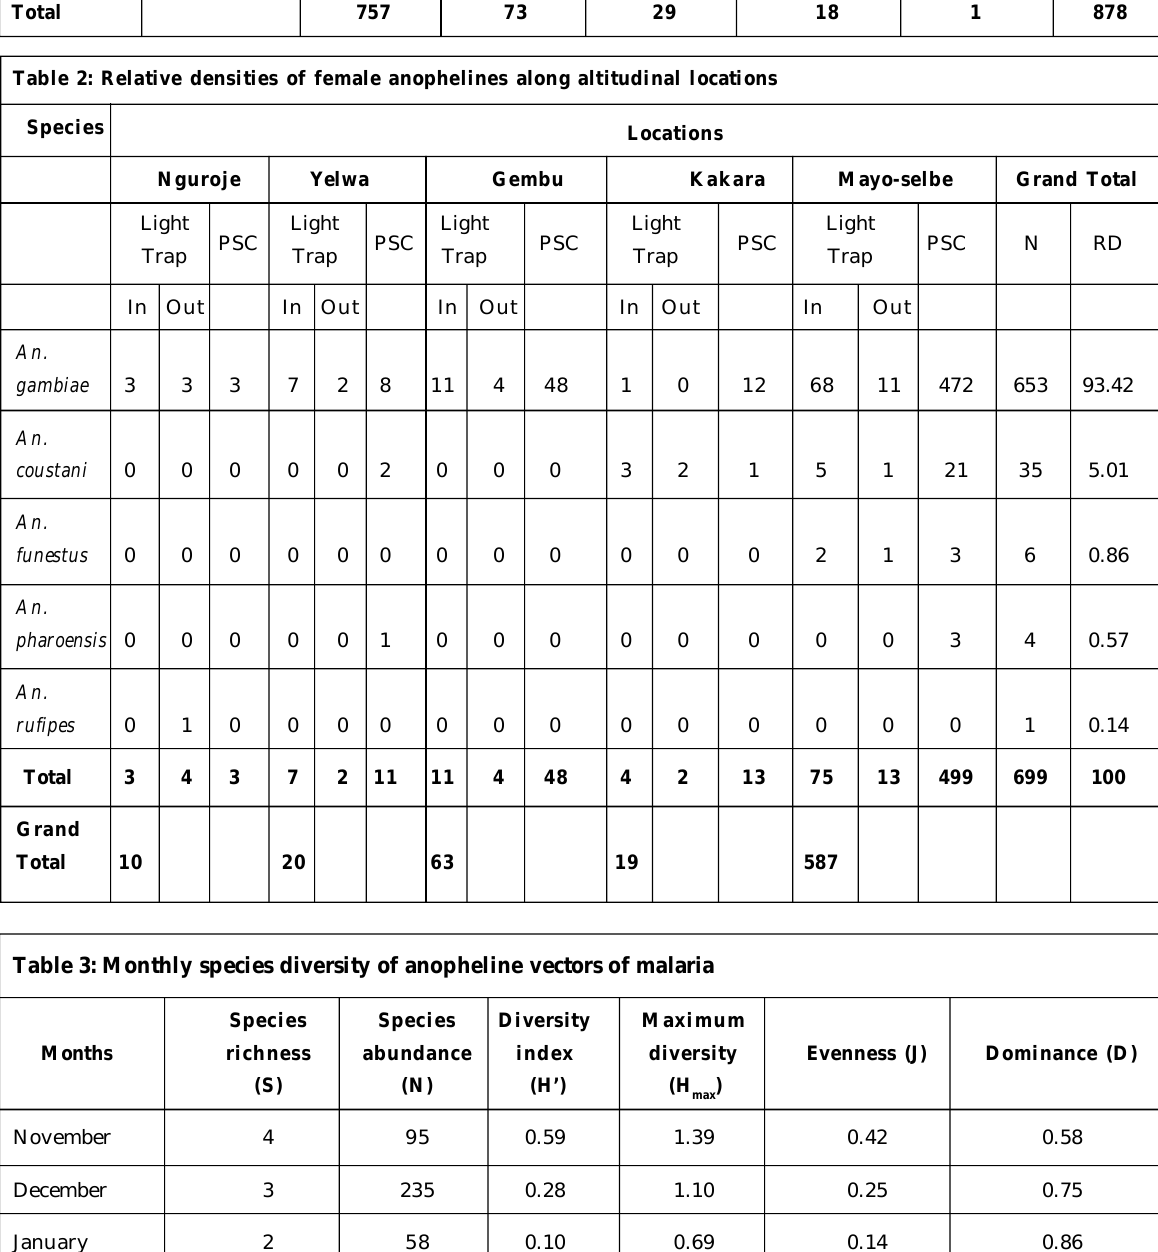
Table 2: Relative densities of female anophelines along altitudinal locations